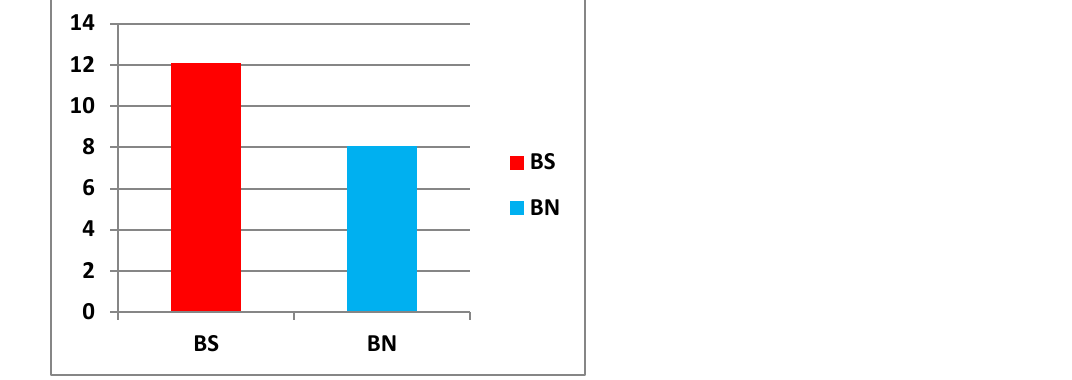
Figure (5) Bupivacaine with normal saline versus bupivacaine with nefopam in term of sensory block onset in minutes, bupivacaine with nefopam show significant statistical difference (p<0.001).